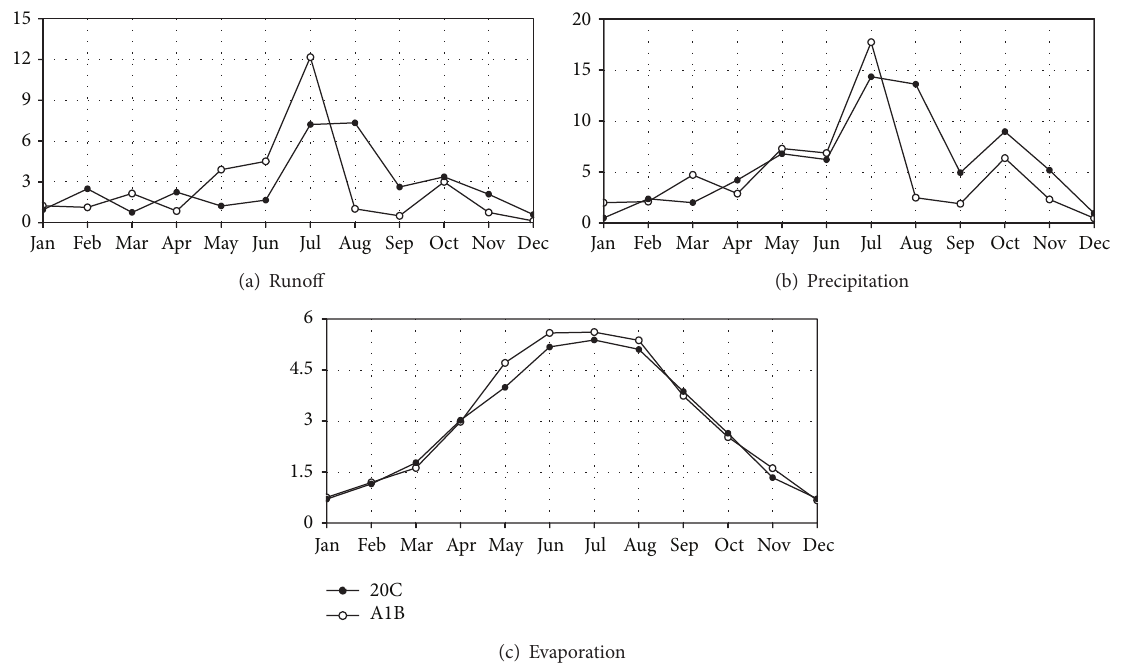
Figure 6: Monthly variations of simulated (a) runoff, (b) precipitation, and (c) evaporation (mm d −1 ) obtained from 20C (closed circle) and A1B (open circle) experiments, over land of Korea (innermost box of Figure